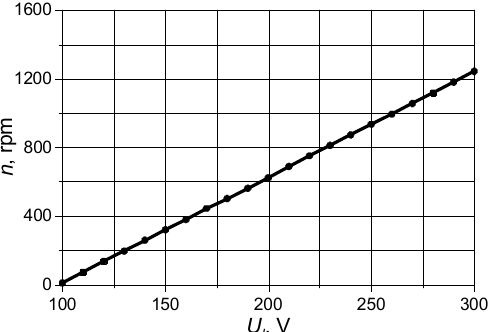
Figure 11. Motor angular velocity (no load condition) as a function of input voltage in closed-loop operation.